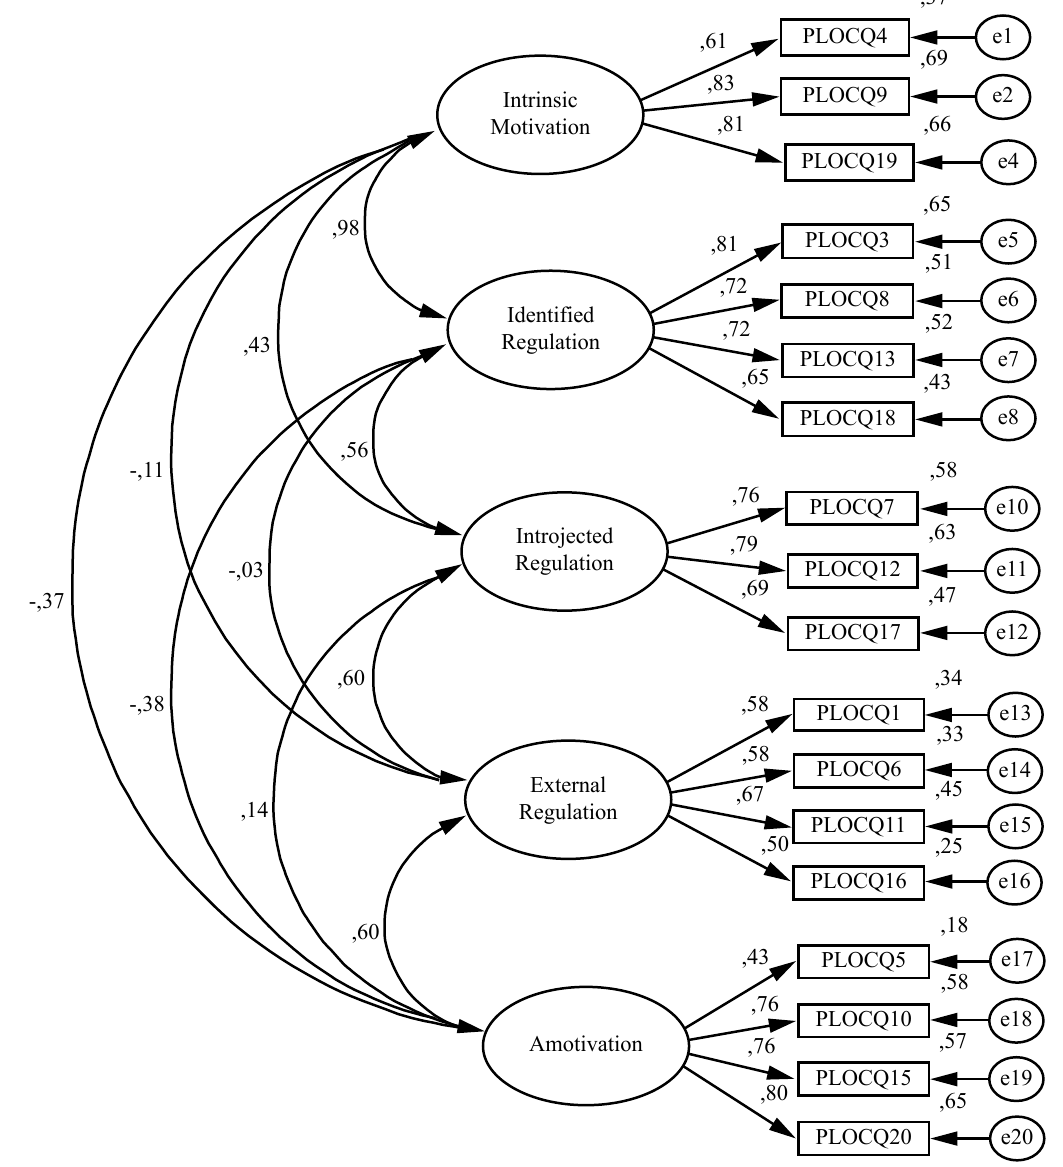
Figure 2 Standardized individual parameters (covariance factors, factorial weights and measurement errors), all of which were signiicant in the measurement model (PLOCQp - Five factors/18 items) for the Portuguese validation sample